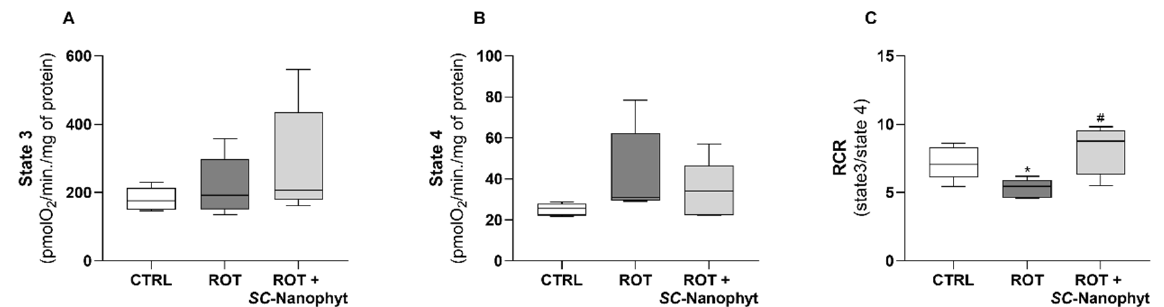
Figure 4. Mitochondrial respiration parameters were obtained with fresh preparations of BG-Cereb portion for CTRL, ROT, and ROT + SC -Nanophyt groups, supported by pyruvate/malate and succinate. The respiratory state 3 ( A ) was obtained by adding ADP to oxidize succinate, and state 4 ( B ) was reached after total phosphorylation of ADP. The RCR ( C ) was calculated as the ratio between the oxygen consumption rate in states 3 and 4. Results are expressed as pmolO 2 /min/mg of protein. Error bars represent SEM for n = 5 independent experiments using five animals in each one. * Significantly different from the CTRL group, with p ≤ 0.05. # Significantly different from the ROT group, with p ≤ 0.05.